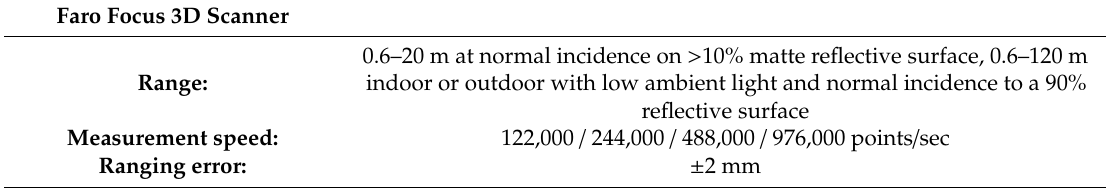
Table 1. Faro Focus 3D specifications.